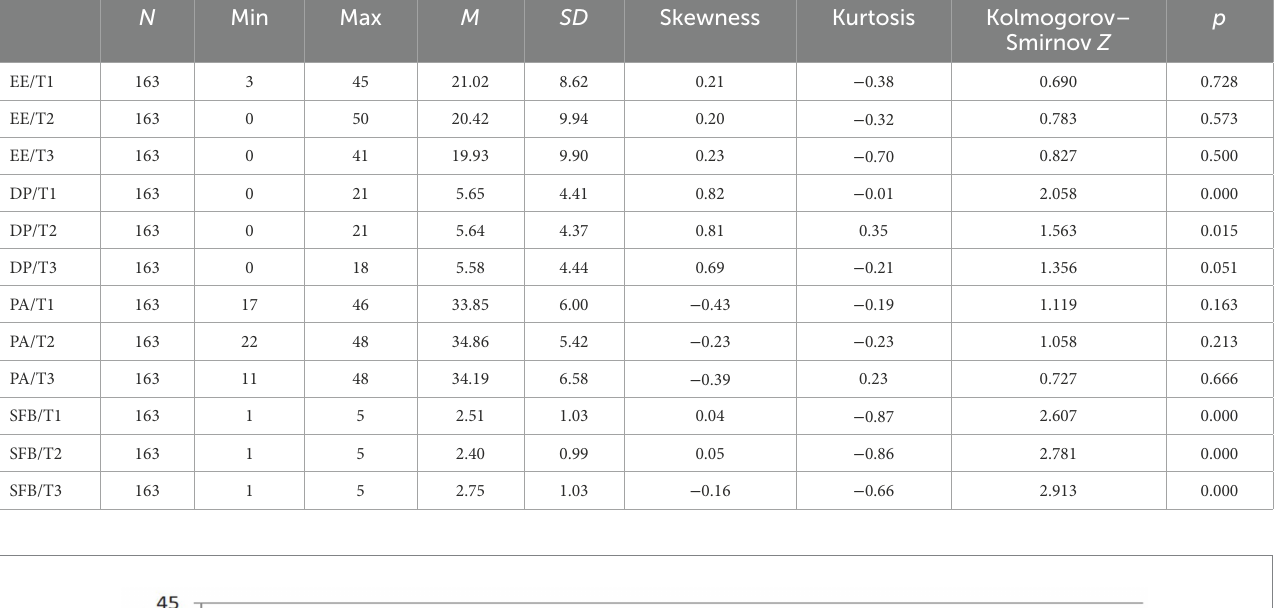
TABLE 3 Descriptive statistics of burnout questionnaire for panel group in three time